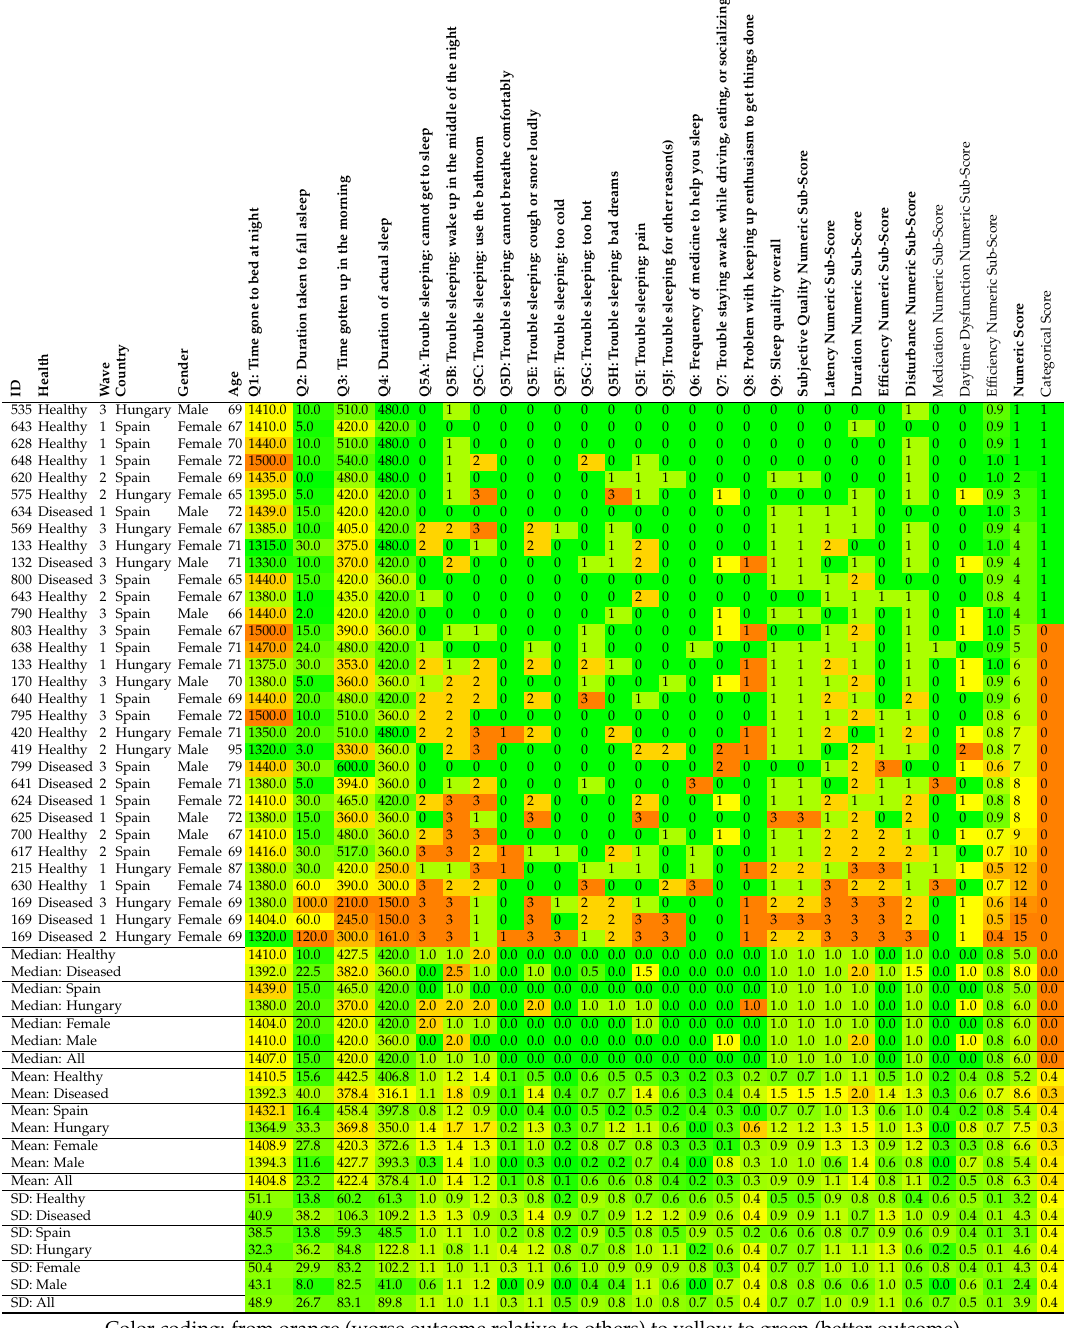
Color coding: from orange (worse outcome relative to others) to yellow to green (better